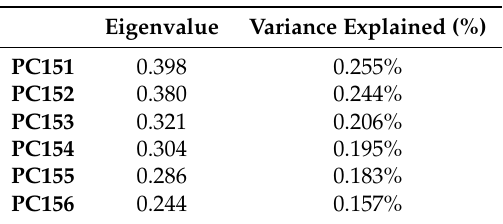
Table 1. Eigenvalues and variances explained by the last six principal components. The percent of variation explained was calculated using Equation